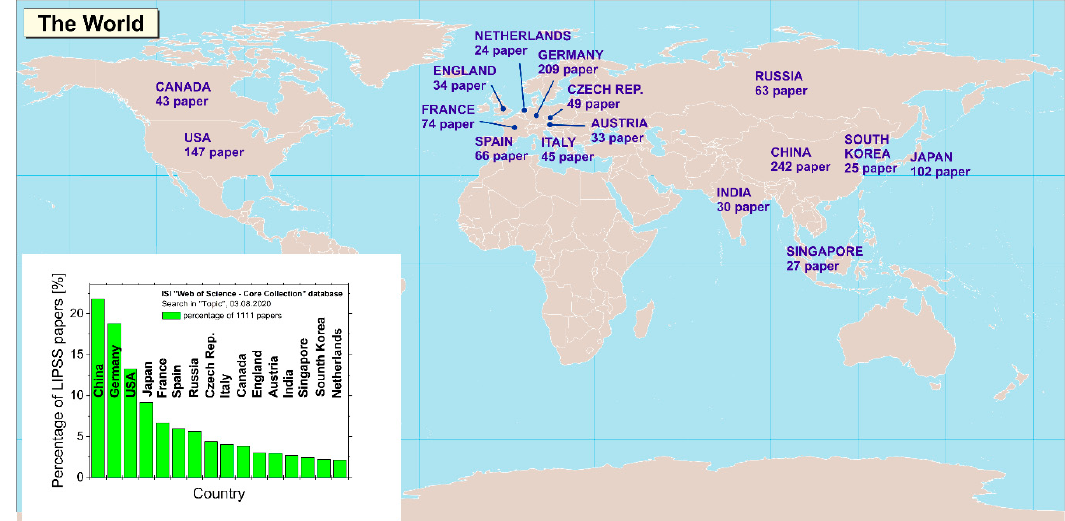
Figure 3. Geographic distribution of research on LIPSS, visualized via the assignment of the 16 countries having published most scientific articles in this field since 1982. The inset ranks the countries according to their percentage on the entire data set consisting of 1111 publications. Table 1 lists the research institutions publishing most actively in the field of LIPSS, ordered by the number of publications and the corresponding percentages. The top three (and, in total, five out of multiple different groups working on LIPSS. Table 1. Top 10 international research institutions with publications associated to the scientific topic of LIPSS, evaluated on basis of the “ISI Web of Science” database 1 .